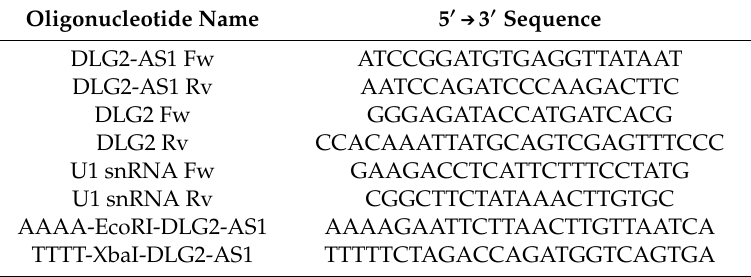
Table A1. Sequences of used oligonucleotides for qPCR and vector cloning.